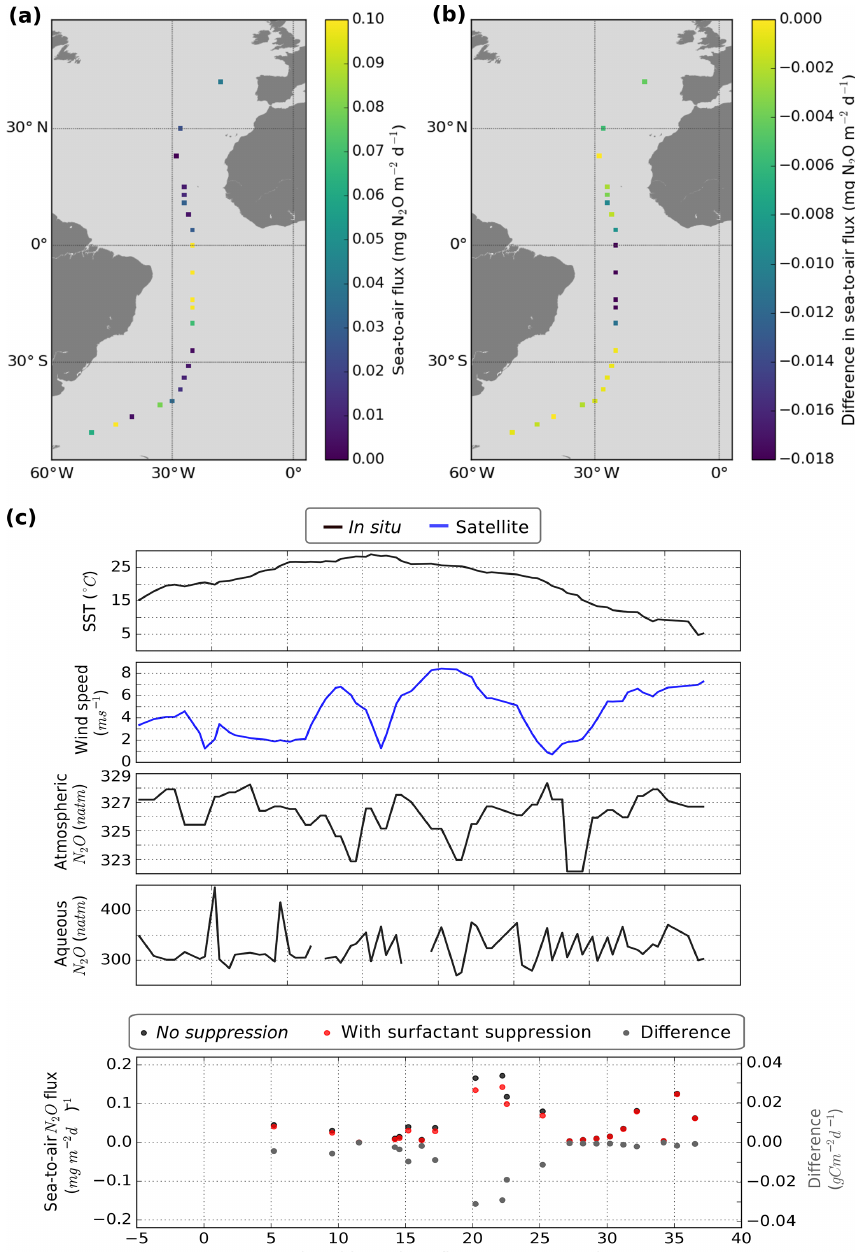
Figure 6. (a) Sea-to-air N 2 O flux taking into account surfactant suppression. (b) Change in N 2 O flux resulting from surfactant suppression. (c) Time series of SST, wind speed, atmospheric N 2 O, aqueous N 2 O, and sea-to-air